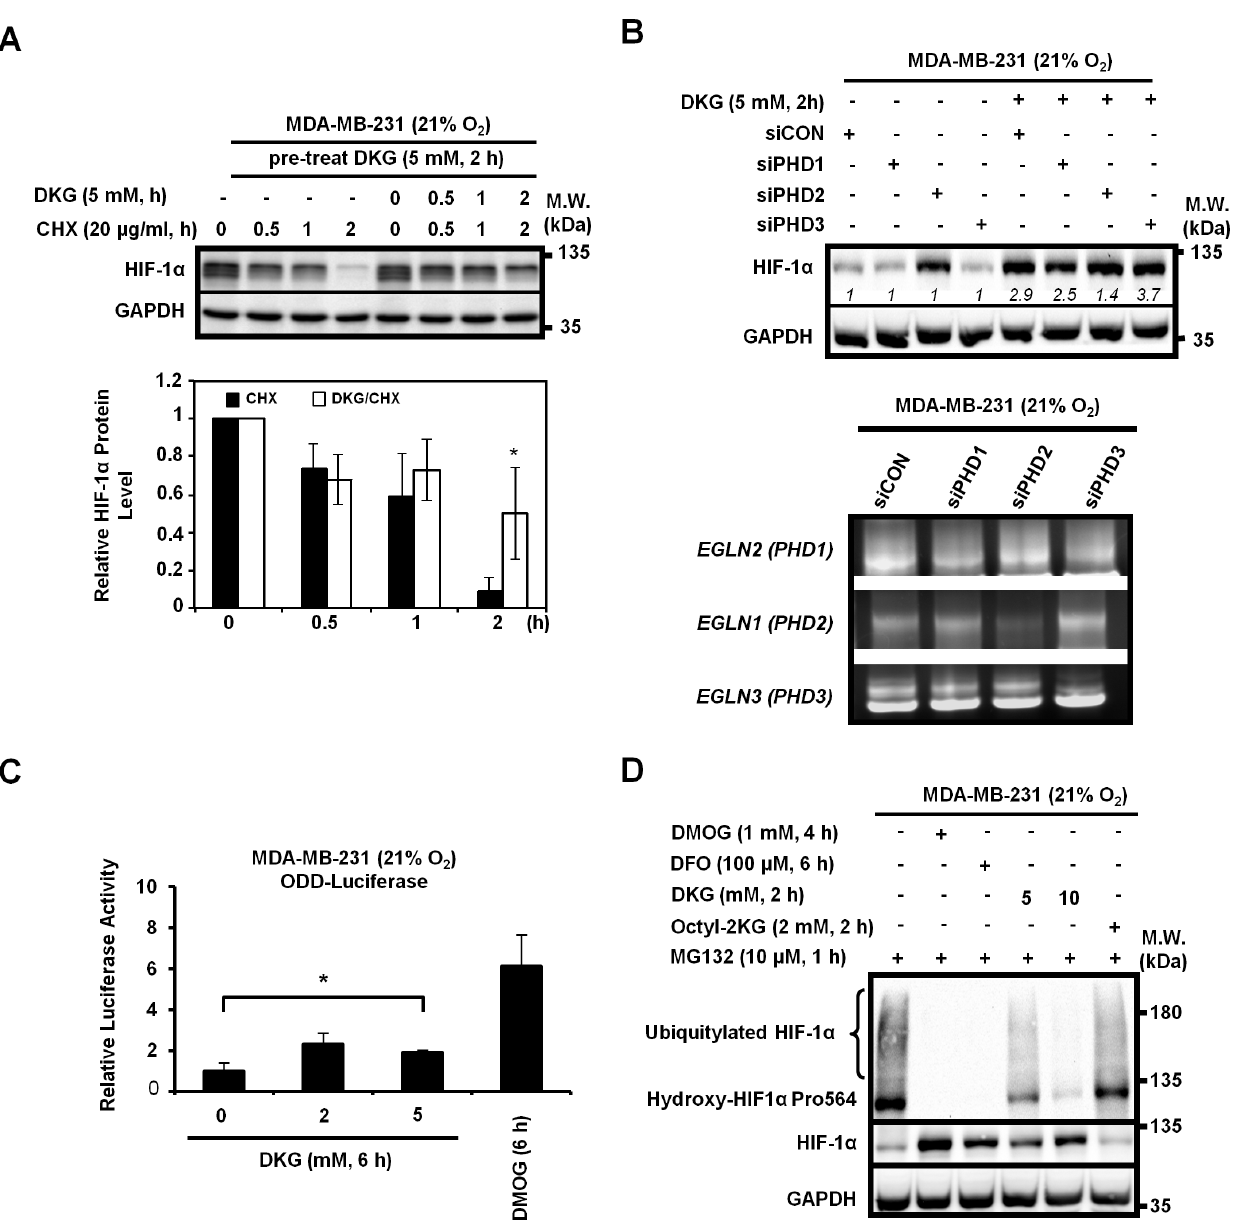
Figure 3. DKG stabilizes HIF-1 a by inhibiting HIF-1 a proline hydroxylation and degradation. ( A ) DKG increases HIF-1 a protein stability. MDA-MB-231 cells were pretreated with DKG (5 mM, 2-hour), then treated with CHX (20 m g/ml) in the presence or absence of DKG (5 mM) for an additional time period as indicated ( upper panel ). The relative abundance of HIF-1 a is shown ( lower panel ). * : p , 0.05; n 5 3. ( B ) DKG blocks HIF-1 a degradation mediated by PHD2. MDA-MB-231 cells were transfected with control siRNA or siRNAs targeting PHD1, PHD2 or PHD3 before treating with DKG (5 mM, 2-hour) (upper panel). Italic numbers represent the relative quantitation of protein levels. The level in the untreated sample from each pair of siCON-transfected, untreated cells was set as 1. The extent of respective knockdown of PHD1, 2 or 3 was assessed with semi-quantitative nested RT-PCR, followed by agarose gel electrophoresis ( lower panel ). ( C ) DKG increases HIF-1 a stability through its oxygen-dependent degradation domain (ODD). ODD-luciferase activity was assayed in MDA-MB-231 cells co-transfected with ODD-luciferase reporter and control renilla luciferase reporter and treated with increasing doses of DKG for 6-hour. DMOG-treated cells serve a positive control. * : p , 0.05; n 5 3. ( D ) Hydroxylation at Pro564 of HIF-1 a is inhibited by DKG. MDA-MB-231 cells were treated with the proteasome inhibitor, MG132, combined with the indicated chemicals to assess the level of HIF-1 a hydroxylated at Pro564. The high- molecular weight, smeared species are the ubiquitylated HIF-1 a . ( A , B , D ) A representative Western image from 3 independent experiments is